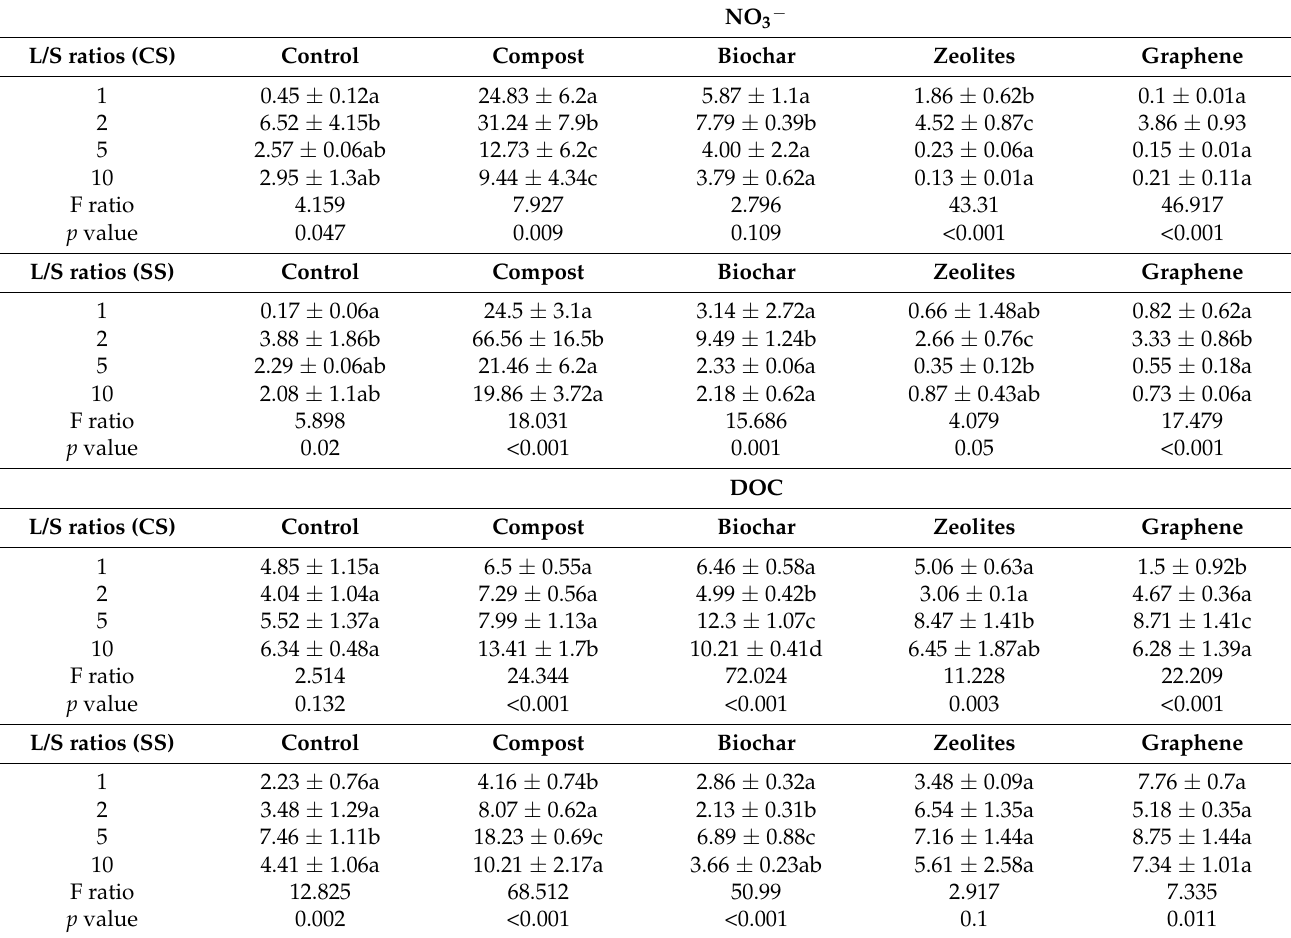
Table 3. Statistical comparison between the mean ( ± standard deviation) of raw data values (not multiplied by the L/S ratios factor) for NO 3 − and DOC at different L/S ratios for each improver for both soils. NO 3